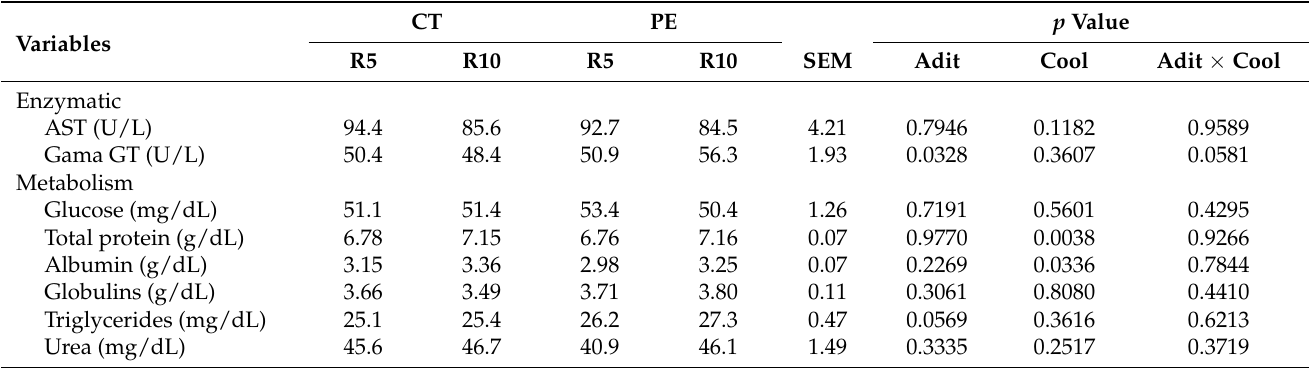
Table 8. Effects of different evaporative cooling regimens and the use or absence of PE on the enzymatic and metabolic status of lactating Holstein cows ( n =